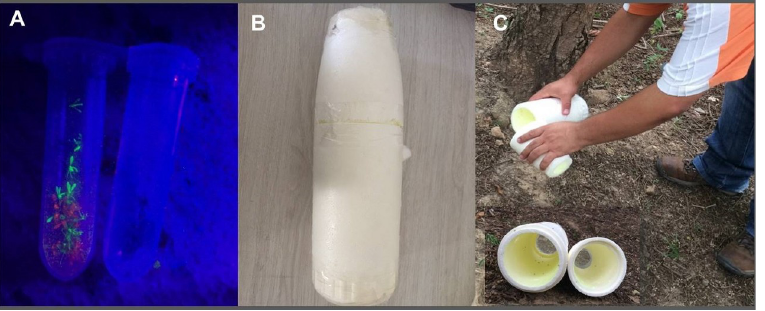
Fig 2. Mark-release-recapture experiments. (A) marked (lime and pink) Lu . longipalpis sand flies (left side) and unmarked ones (right side) under UV lighting, (B) home-made tapered cylinder device, and (C) release of sand flies in the field (insert lower left showing the two parts opened for quick release of the contents).